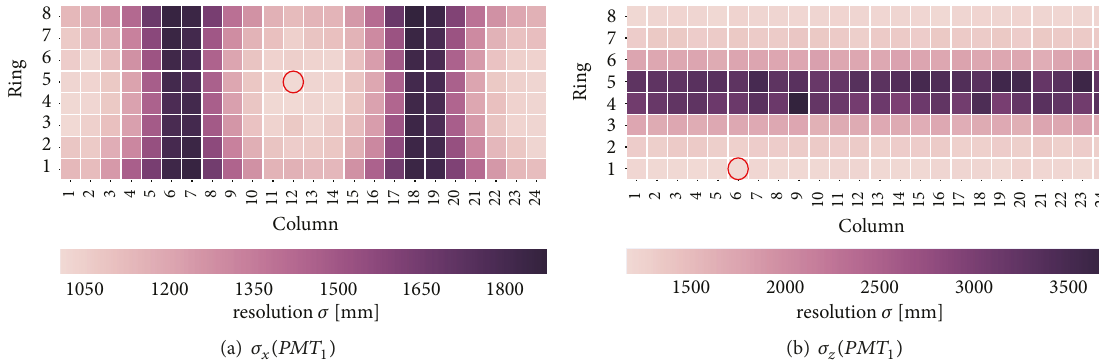
Figure 3: Resolution 𝜎 corresponding to using each individual PMT for (a) 𝑥 and (b) 𝑧 , using the brute force search. In each heatmap, the circled PMT corresponds to the best resolution amongst all the 192 PMTs.